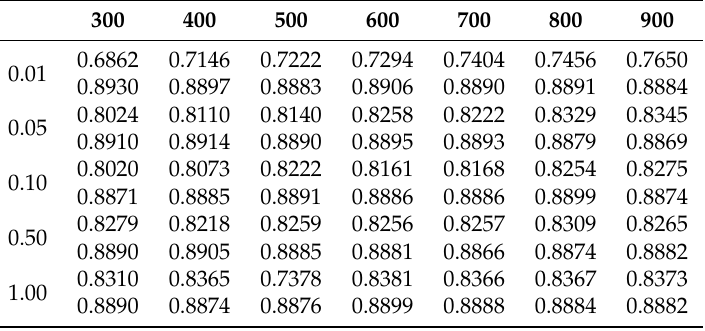
Table 7. OA on different values of sparsity and number of hidden nodes over San Francisco Bay image by two classification networks based on AE and the proposed